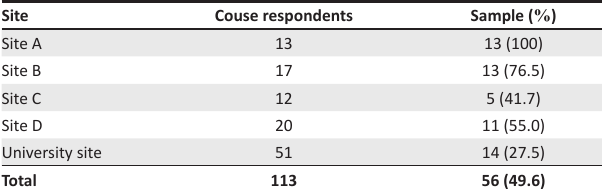
TABLE 1: Respondents of the